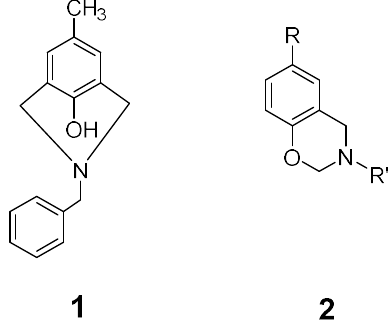
Figure 1. Burke’s proposed structures.